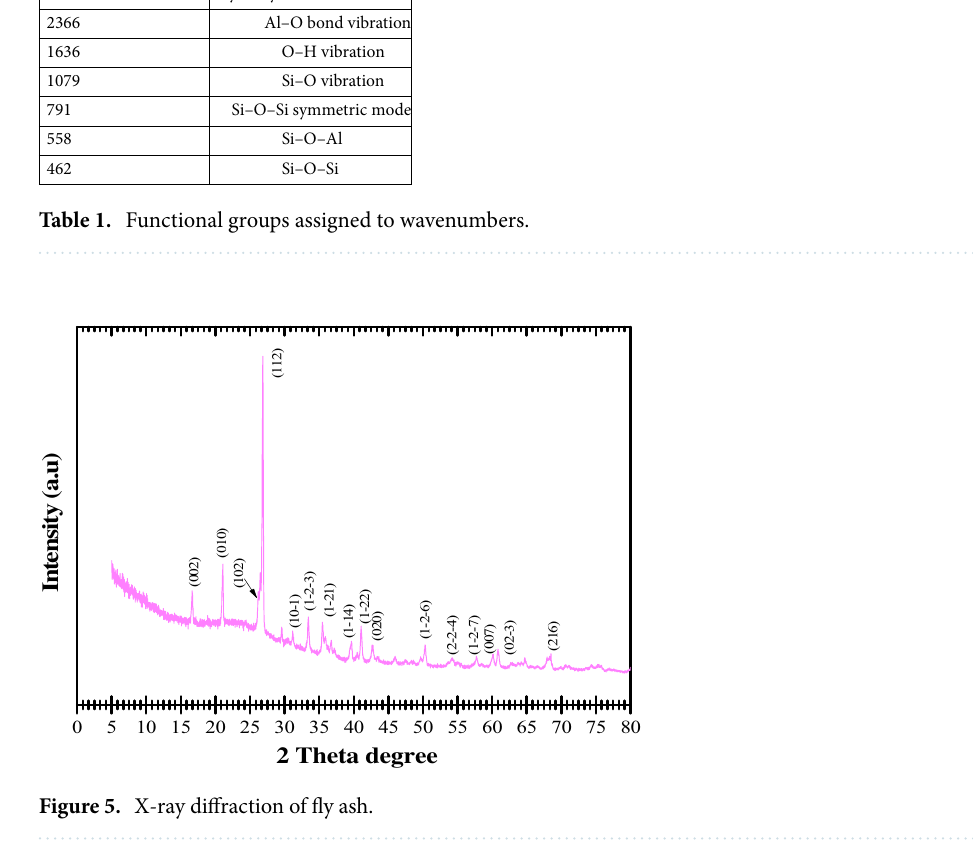
Figure 5. X-ray diffraction of fly